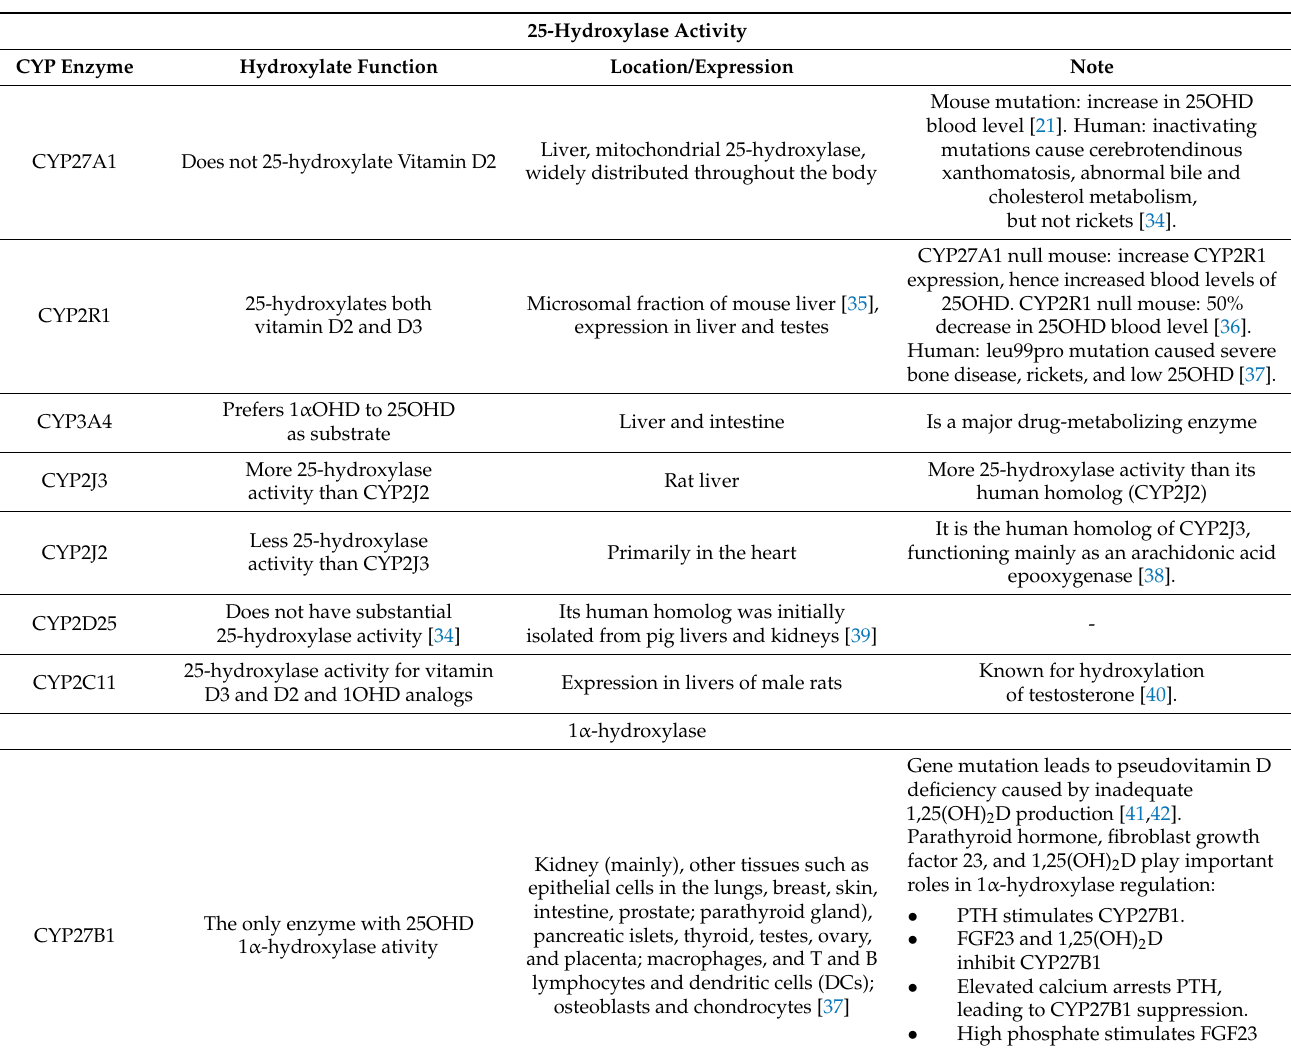
Table 1. CYPs that are mainly involved in Vit D metabolism. 25-Hydroxylase Activity